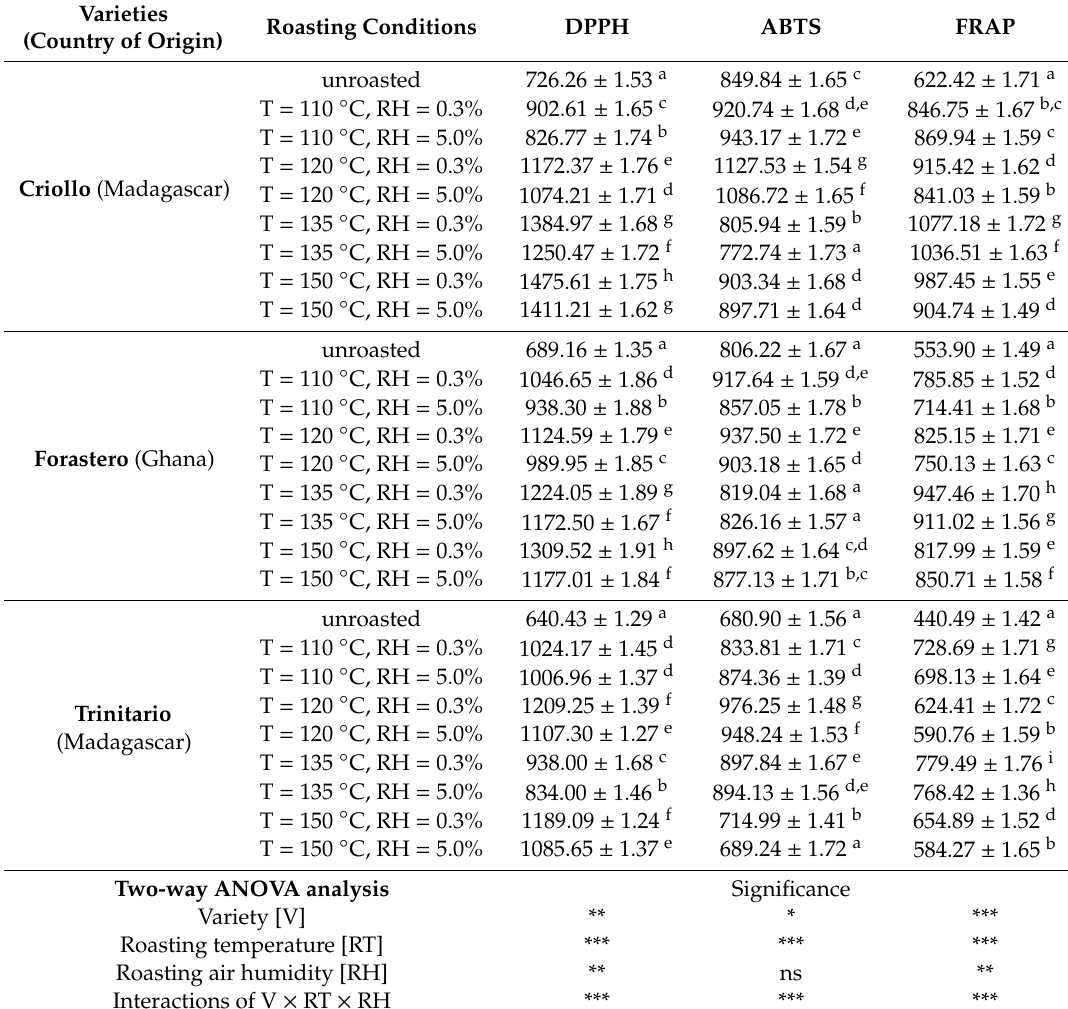
Table 2. The free radical scavenging capacity (2,2-diphenyl-1-(2,4,6-trinitrophenyl) hydrazyl (DPPH) and 2,2 (cid:48) -azino-bis (3-ethylbenzothiazoline-6-sulfonic acid) diammonium salt (ABTS)) and ferric reducing ability (FRAP) of high-molecular weight (HMW) fractions isolated from raw and roasted at di ff erent conditions cocoa beans of Criollo, Forastero, and Trinitario groups originating from various geographical